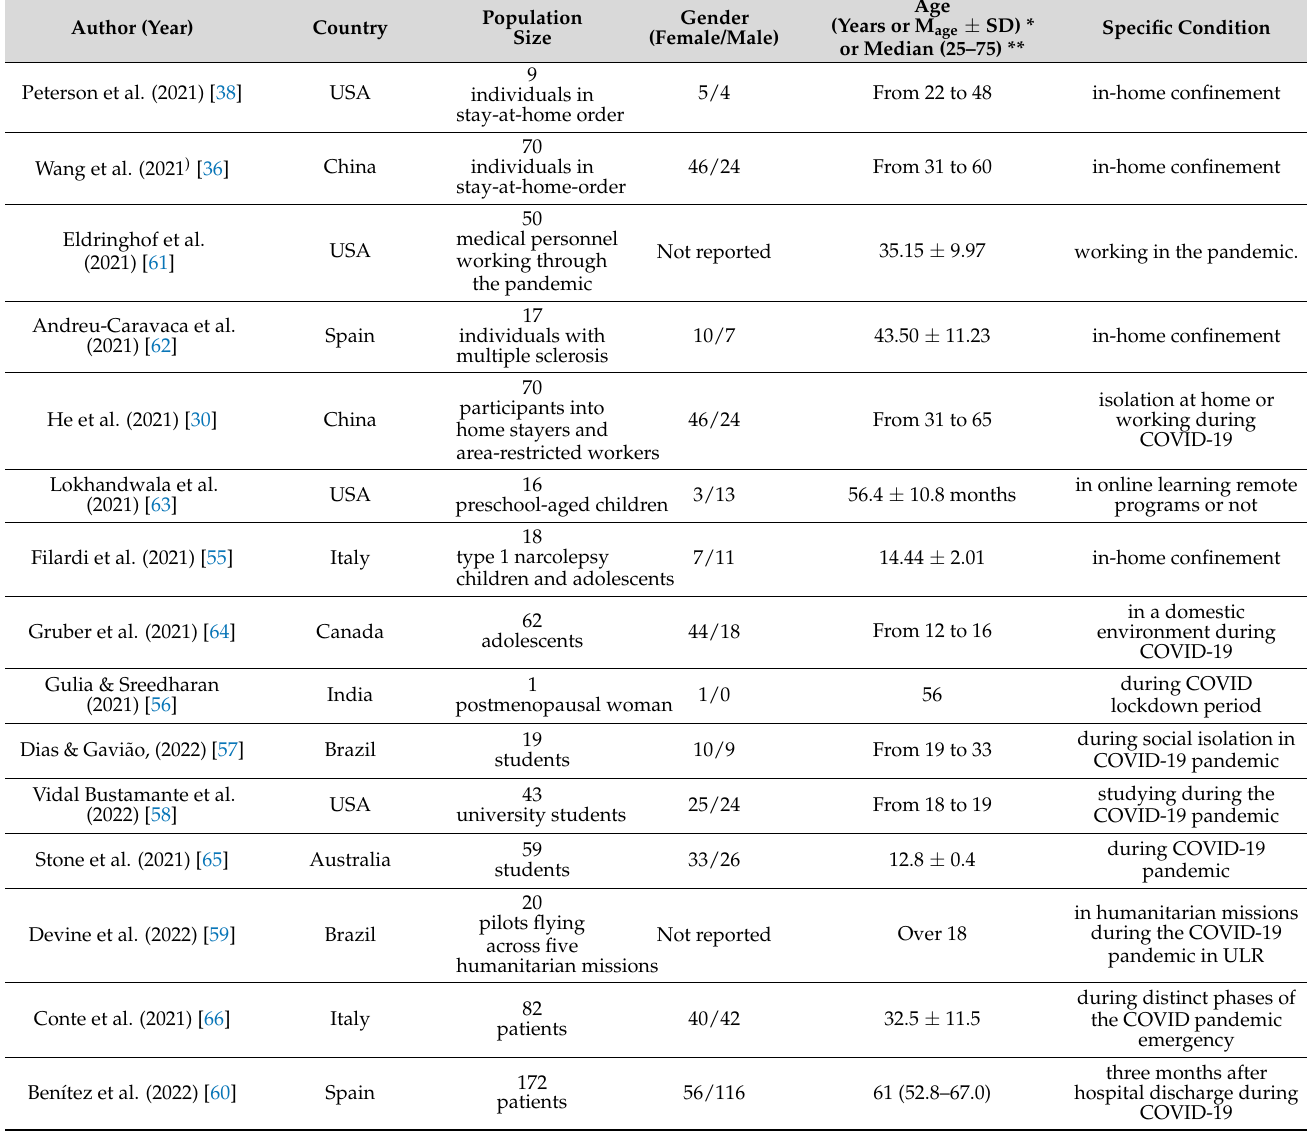
Table 1. Individual characteristics inf the selected studies regarding the author, year, country, popula- tion size, gender, age, and specific condition during